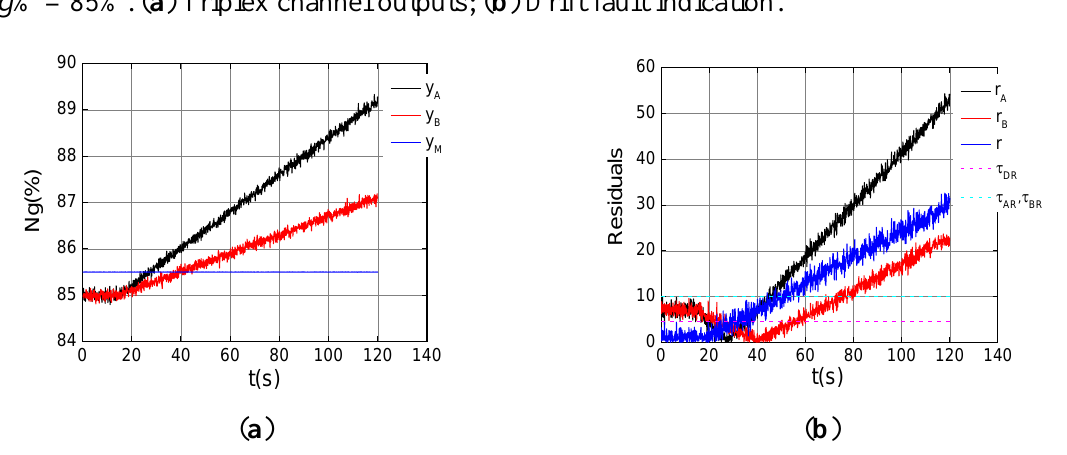
Figure 10. Dual channel fault with different drift velocities under the steady state of ng % = 85%. ( a ) Triplex channel outputs; ( b ) Drift fault indication.